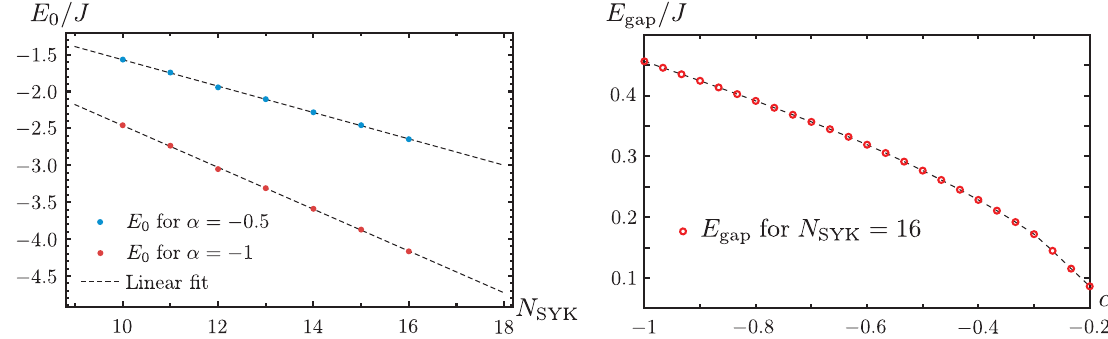
10 ; 11 ; … ; 16 (the number of samples are 250 000,120 000, SYK ¼ 16 SYK ¼